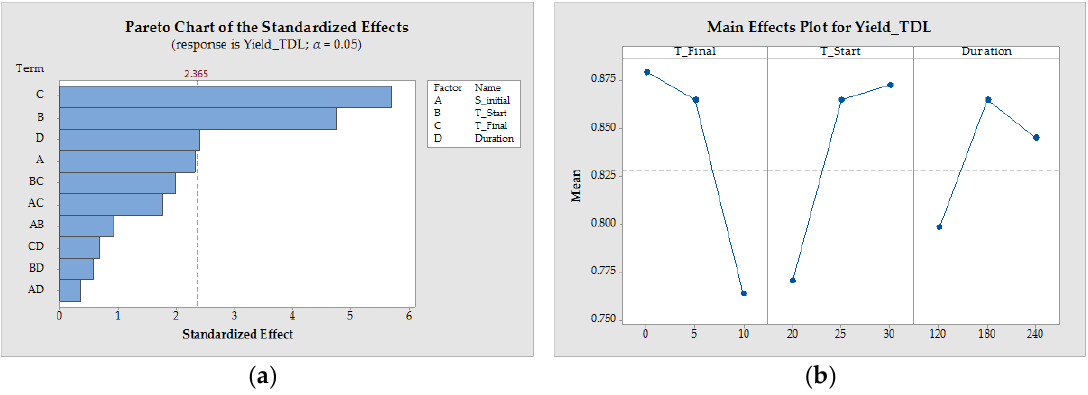
Figure 8. Influences on Yield TDL : ( a ) significances and ( b ) main effects (TDL: Thermodynamic limit).